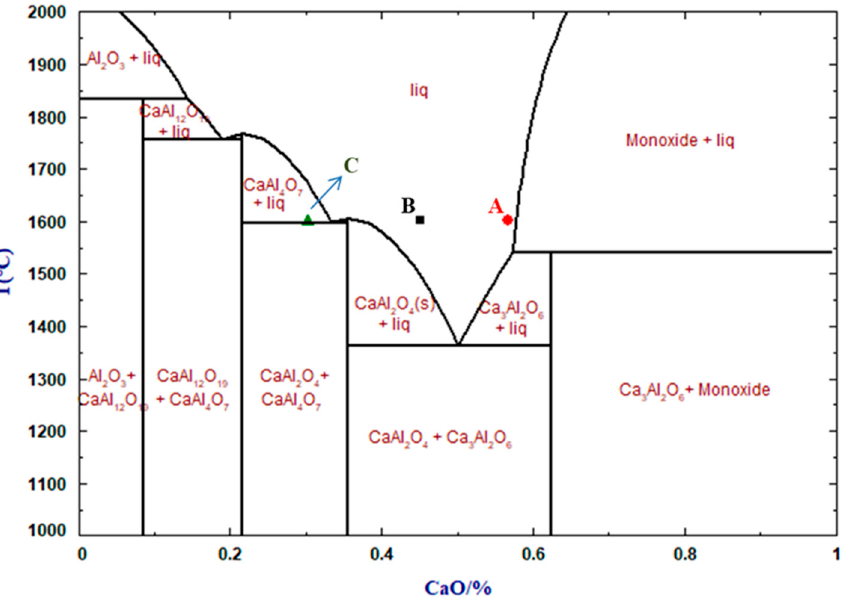
Figure 6. CaO–Al 2 O 3 binary phase diagram. Figure 6. CaO – Al 2 O 3 binary phase diagram.